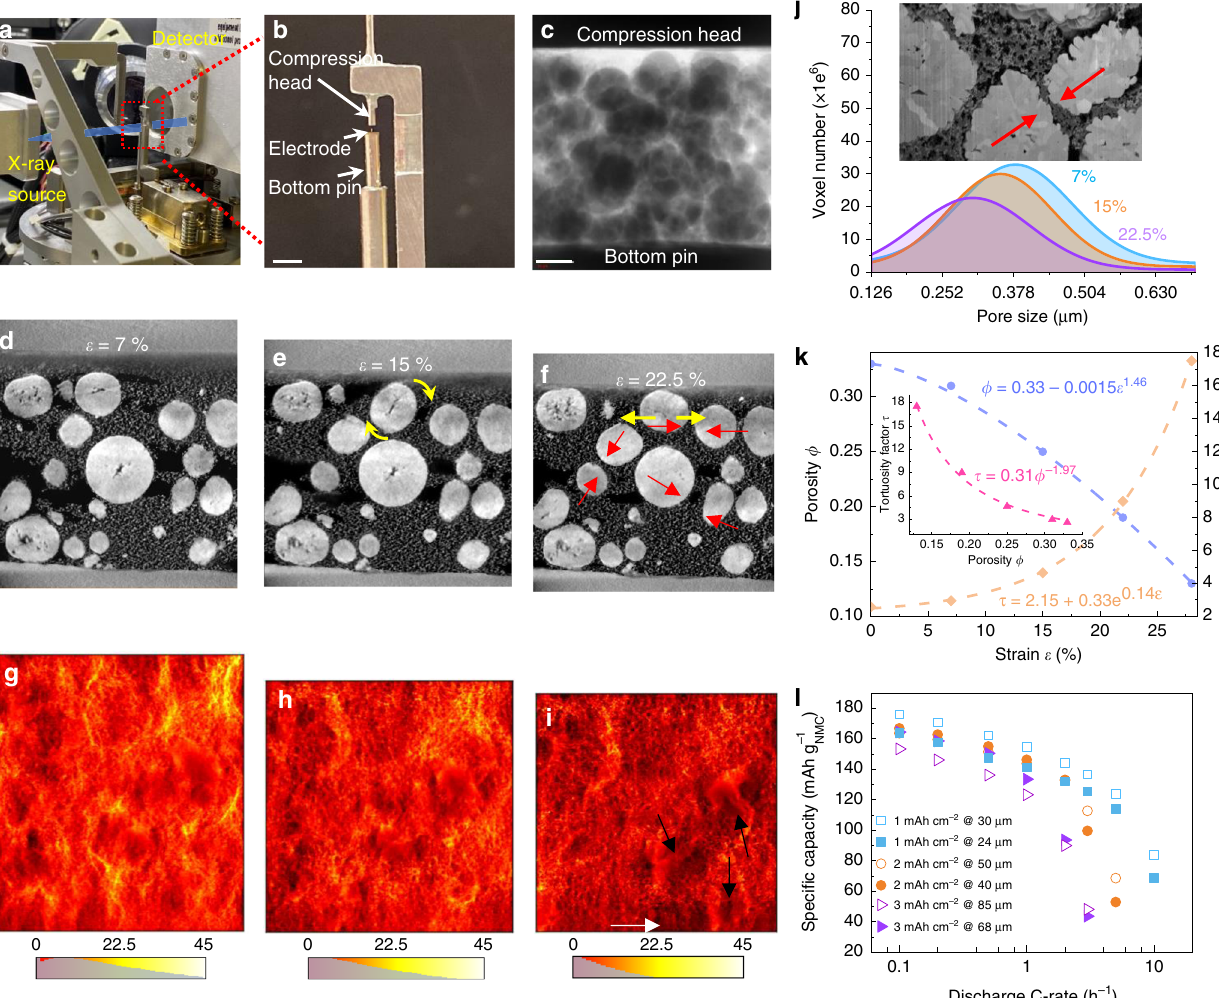
Fig. 9 Calendering effect on electrode microstructure and performance. a Experimental setup of the time-lapse X-ray nano-CT; b magni fi ed image showing the details of the alignment; c X-ray radiograph before the compression; d − f slices from nano-CT images showing the electrode microstructural evolution under incremental calendering steps; g − i simulated mass fl ux map in the calendered pore structures respectively, with the colour legend overlaid by the fl ux histogram; j pore size distribution at incremental calendering steps. The inset displays the ‘ crushed ’ CBD and loss of porosity; k quanti fi cation of the microstructural parameters as a function of calendering steps based on the reconstructed 3D volumes; l experimental electrochemical performance comparison between electrodes of three mass loadings, calendered and uncalendered. The scale bar in ( b , c ) represents 2 mm and 10 μ m